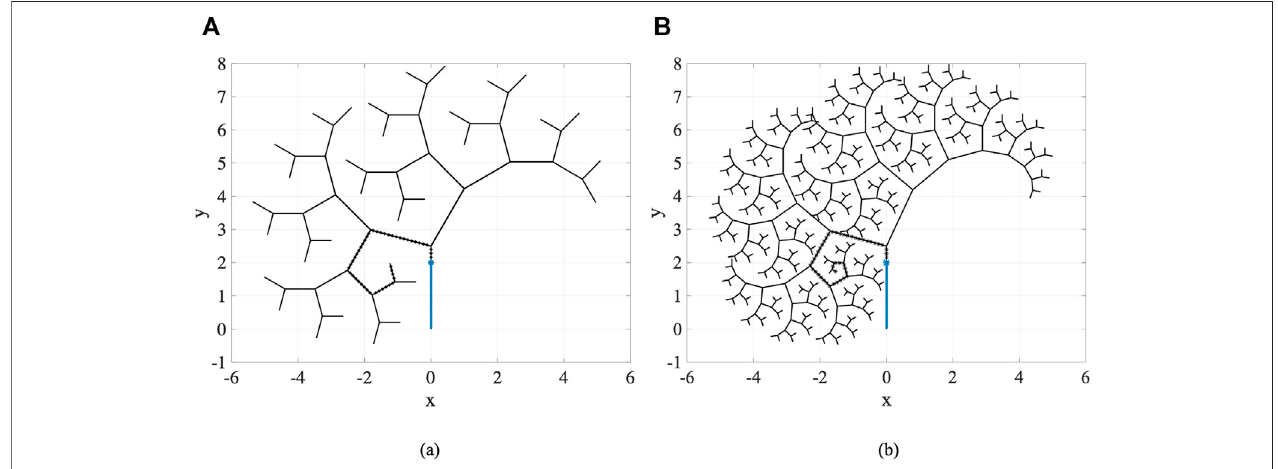
ϕ (cid:1) − π and (b) n br (cid:1) 9 , λ 1 (cid:1) 0 . 7 , λ 2 (cid:1) 0 . 75 , ϕ 1 (cid:1) 5 π 2 12 , 6